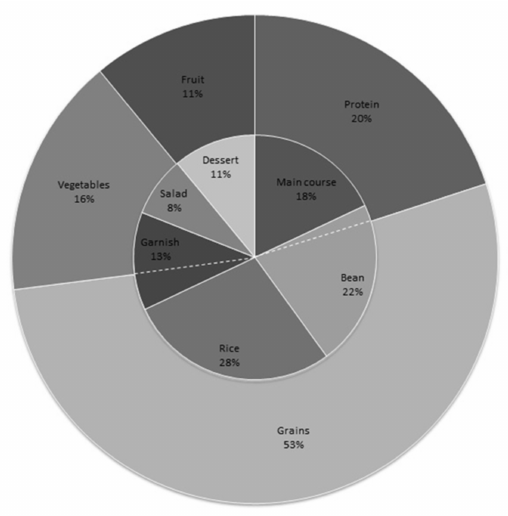
Figure 1. Plate composition by type of preparation consumed by low-income Brazilians in Popular Restaurants and distribution according to recommend groups of “My plate” United States Department of Agriculture (USDA)